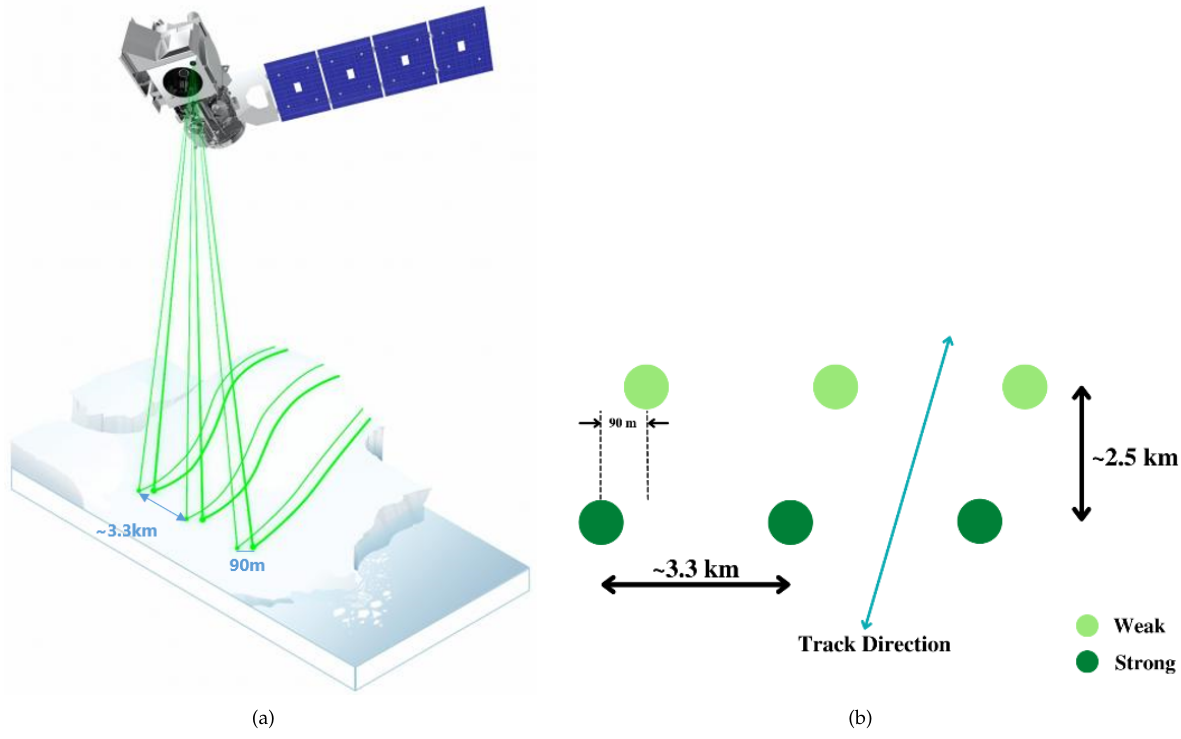
Figure 2. ICESat-2/ATLAS beams. ( a ) Schematic diagram of the operation of ICESat-2; ( b ) Flight orbit and photon